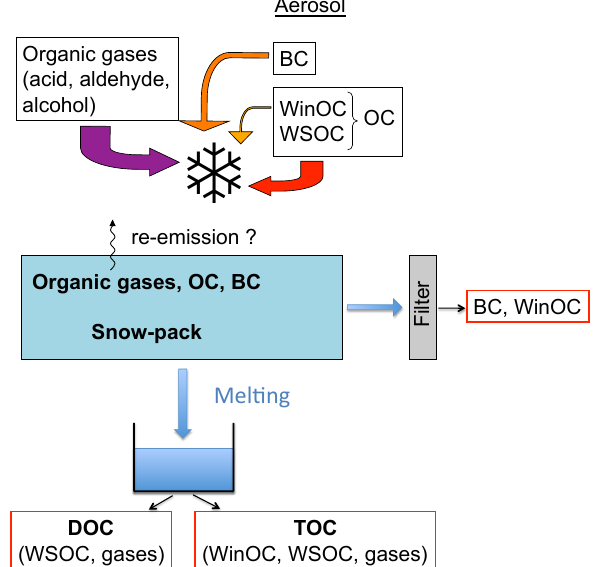
Fig. 8. The different atmospheric organic fractions trapped in ice. They include black carbon (BC), organic carbon (OC) and its two sub-fractions (water-soluble and water-insoluble organic car- bon denoted WSOC and WinOC, respectively). DOC and TOC re- fer to dissolved and total organic carbon, respectively. Adapted from Legrand et al. (2013).